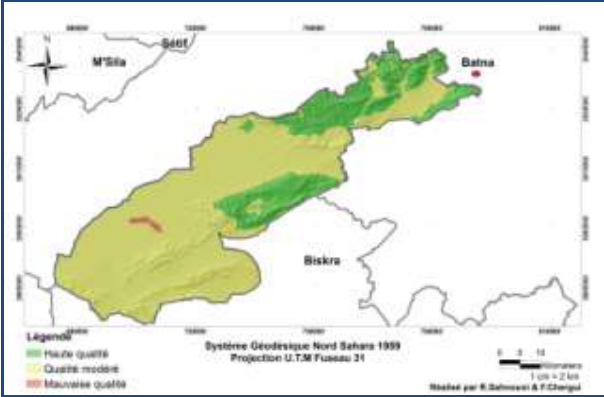
Figure2. Soil quality map of southern massif Belezma The high soil quality category occupies an area of 1,341 km ² or 53.63% of the total area, with a quality index below 1.33. This class is mostly occupied by forest vegetation, is less subject to human pressure than the other two. This explains better soil stability and lower impacts of erosion. The moderate class covers an area of 595.47 km ² or 23.81% and has an index between 1.33 and 1.45. It is mostly spread over the central part of the study area. The class of poor quality cover an area of 564,96 km ² or 22.56% of the total area, with a quality index above 1.45 and it occupies the southern part of the case study.